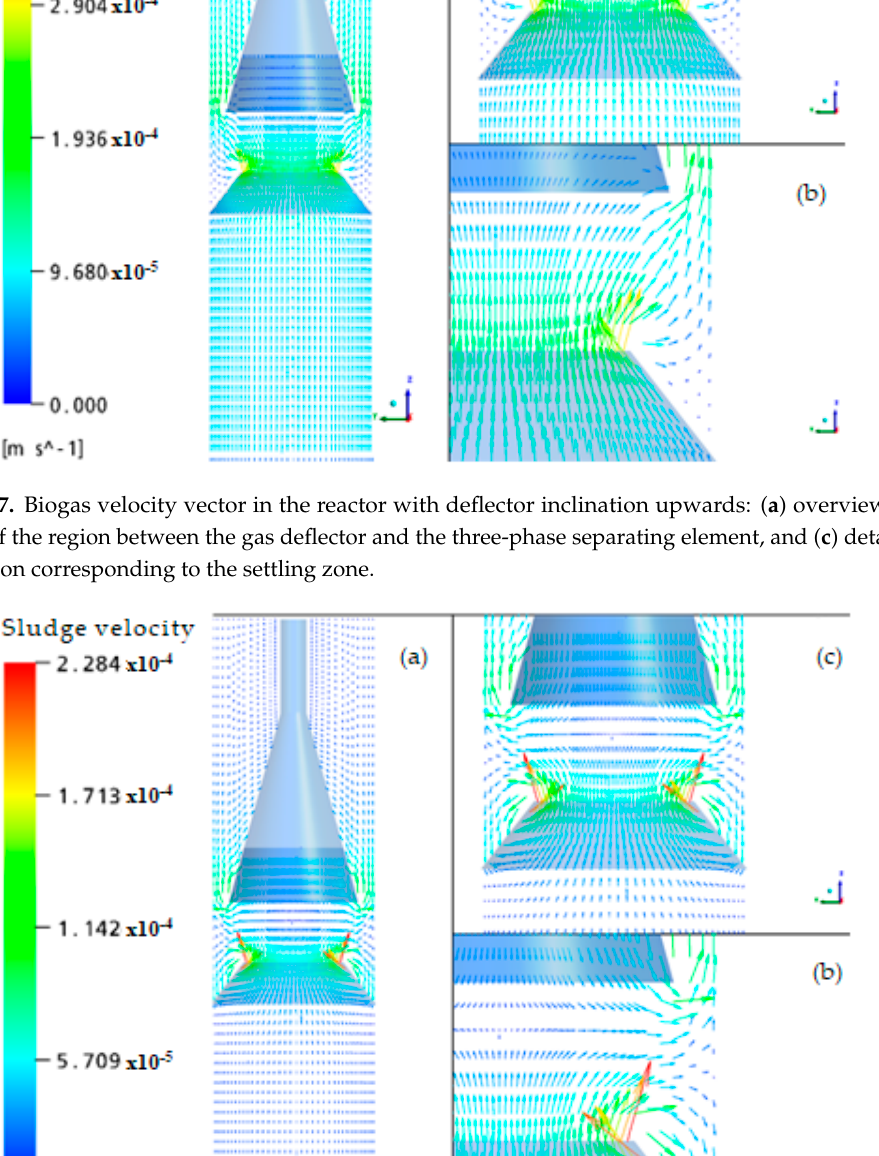
Figure 8. Sludge velocity vector in the reactor with deflector inclination upwards: ( a ) overview, ( b ) detail of the region between the gas deflector and the three-phase separating element, and ( c ) detail of the region corresponding to the settling zone.